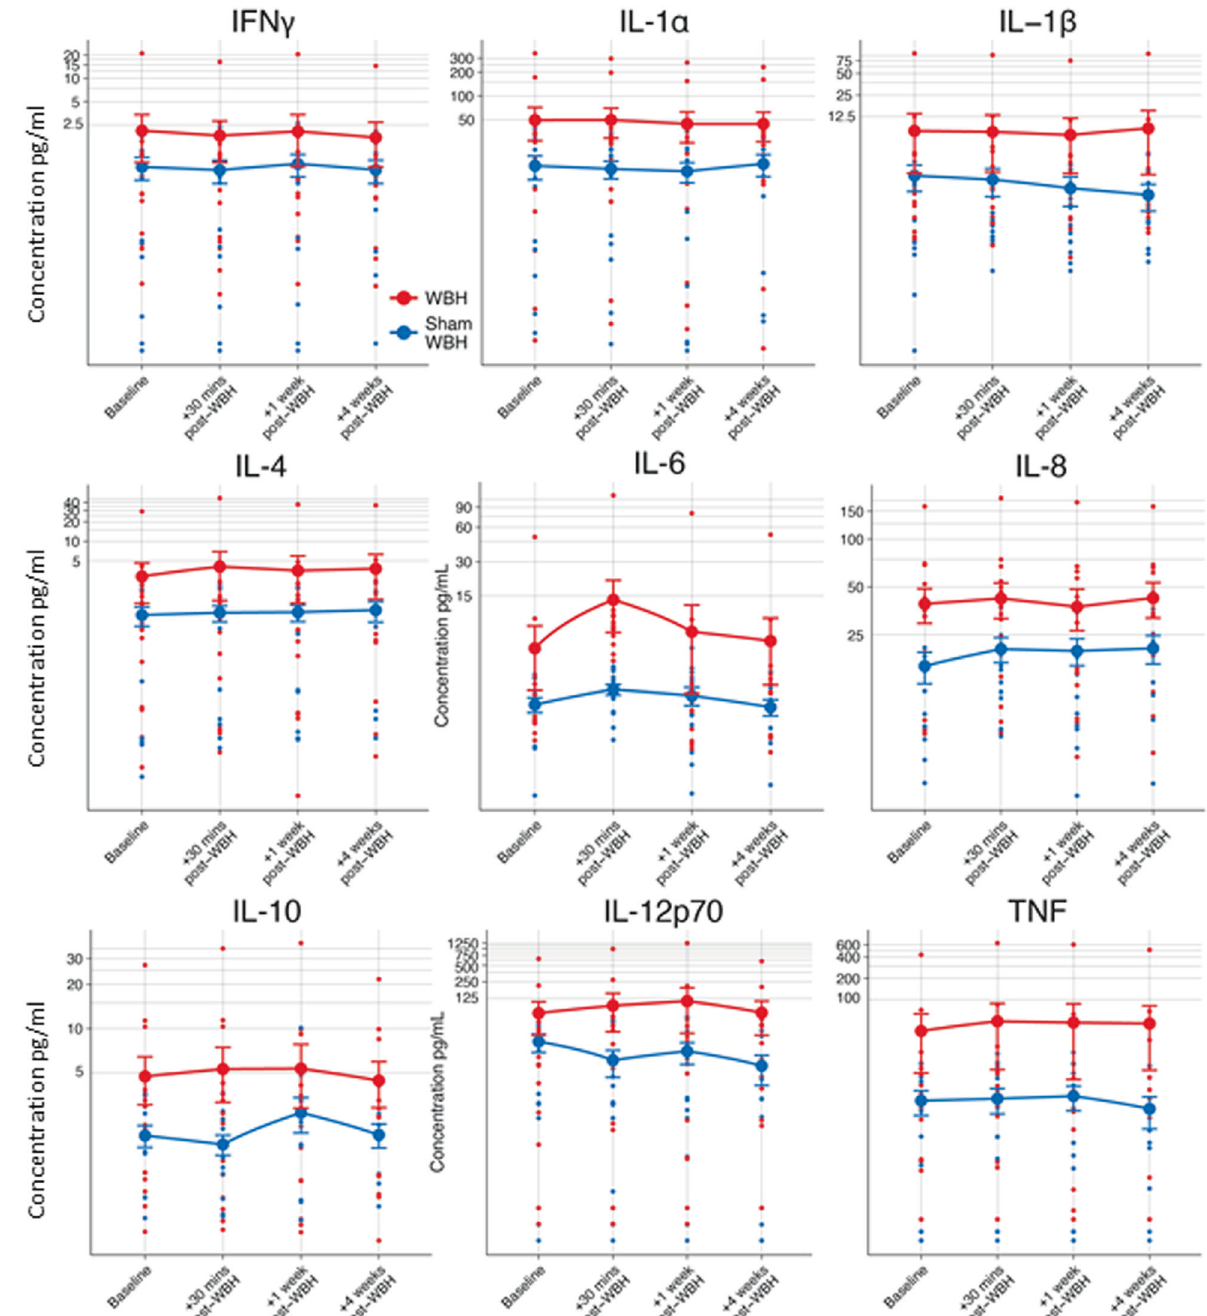
Fig. 2 Changes in plasma cytokine concentrations as measured by multiplex enzyme-linked immunosorbent assay (ELISA) in response to whole-body hyperthermia (WBH; red) and sham WBH (blue). Data are presented as scatter plots showing individual values (smaller points) and as means (larger points connected by a line) ± standard deviation. The y axis is displayed using a log scale to better display the range of concentration values measured while including participants with elevated in fl ammation and to re fl ect that log transformed data were primarily used in all statistical modeling. IFN γ interferon gamma, IL interleukin, TNF tumor necrosis factor, WBH whole-body ( F (1,76.2) = 165, p < 0001), such that IL-6 increased signi fi cantly rapid and sustained reduction of HDRS score when compared to sham treatment in the subset of participants with available immediately following WBH, while showing no difference from cytokine/body temperature data (WBH: n = 15; sham: n = 14). sham at post-treatment weeks 1 and 4 (Fig. 2; Table S2). Likewise, With the exception of IL-6, WBH had no effect on any log analysis of log transformed IL-6 concentrations using chi squared transformed cytokine concentrations, either acutely (i.e., immedi- tests across all time points showed an effect of treatment x time ately post-treatment) or at weeks 1 and 4 post-treatment ( p , n.s.; ( χ 2 (3, N = 112) = 25.21, Bonferroni-corrected p < 0.001) (Fig. 2). While Table S1). Analysis of log transformed IL-6 concentrations using WBH increased core body temperature more than the sham LMM revealed a signi fi cant treatment x time interaction condition ( p < 0.001), it should be noted that the provision of mild